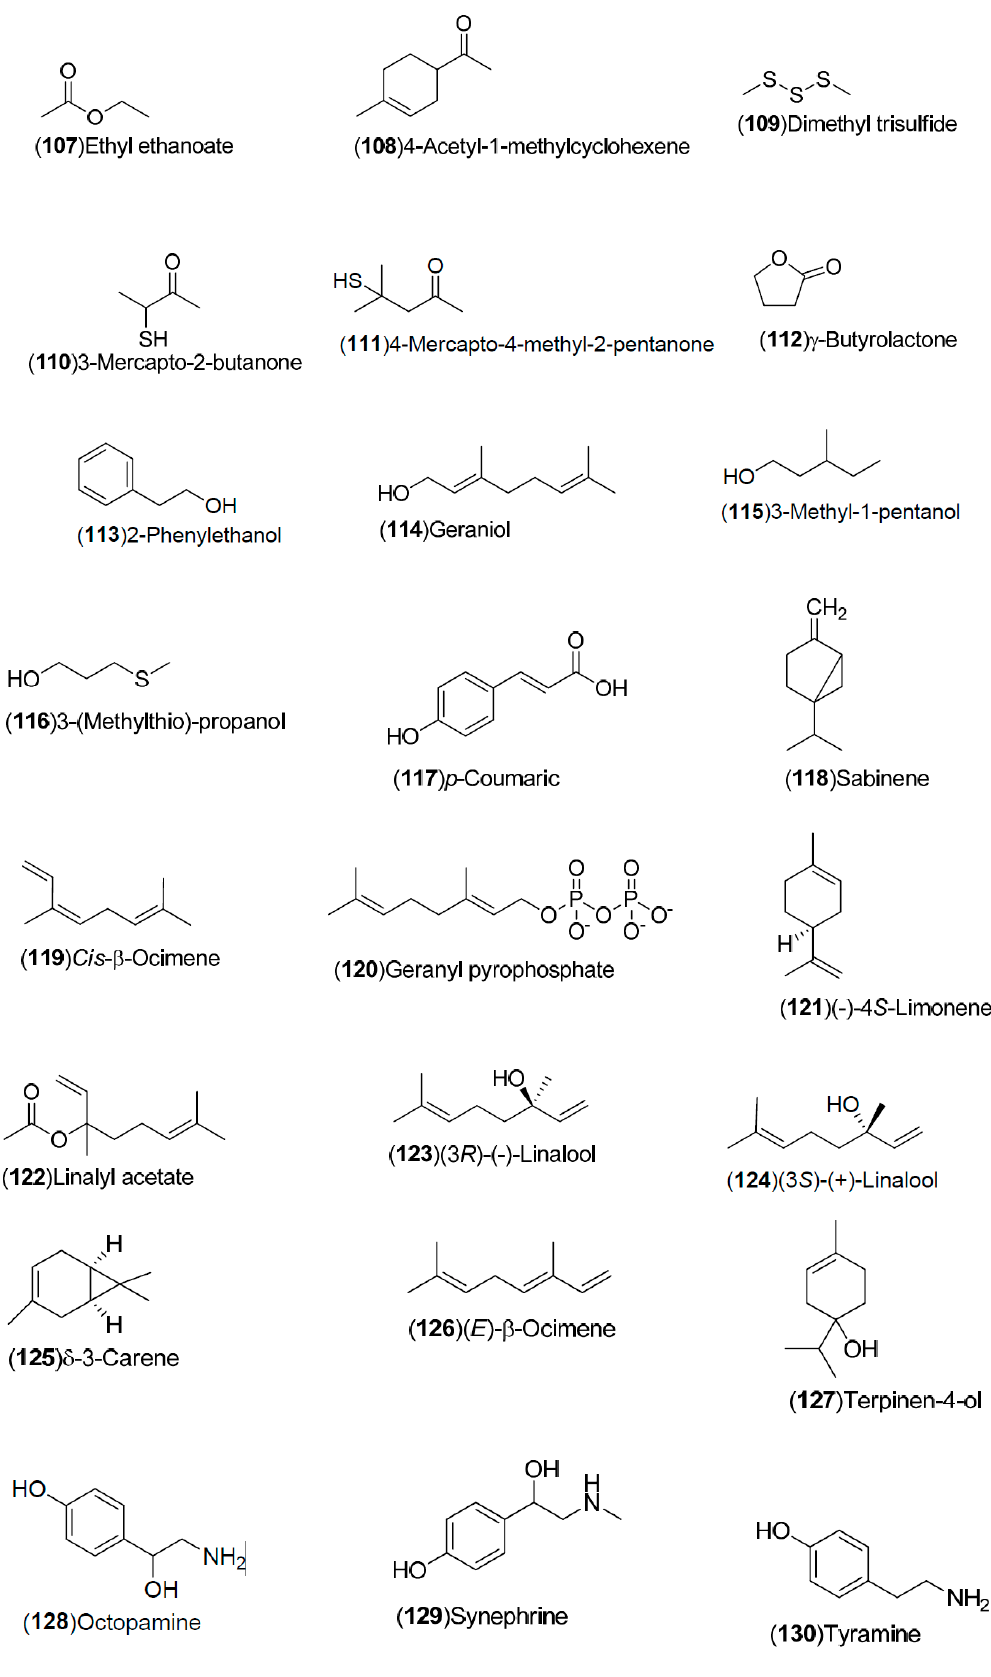
Figure 9. Cont. Figure 9.